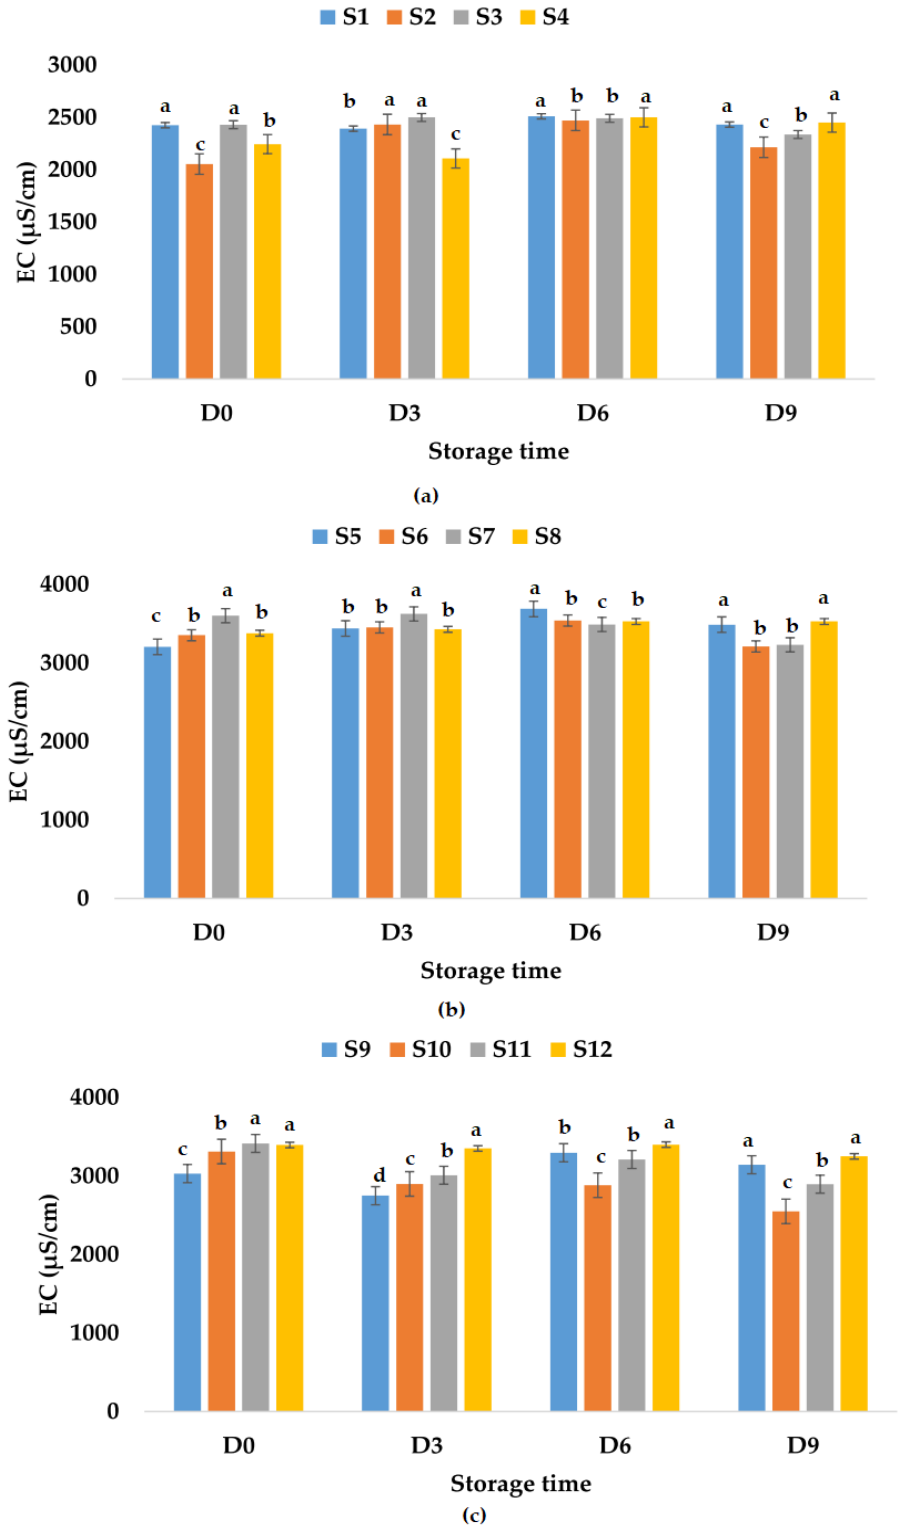
Figure 9. Variation in EC ( µ S/cm) of juice samples during the storage period (D-day) at refrigeration temperature (4 ◦ C): ( a ) apple juice samples (S1, S2, S3, S4); ( b ) apple and pumpkin juice samples (S5, S6, S7, S8); ( c ) apple and pomegranate juice samples (S9, S10, S11, S12). Means with different lowercase letter indicate the significant differences ( p < 0.05) among the samples and were performed separately for each day of